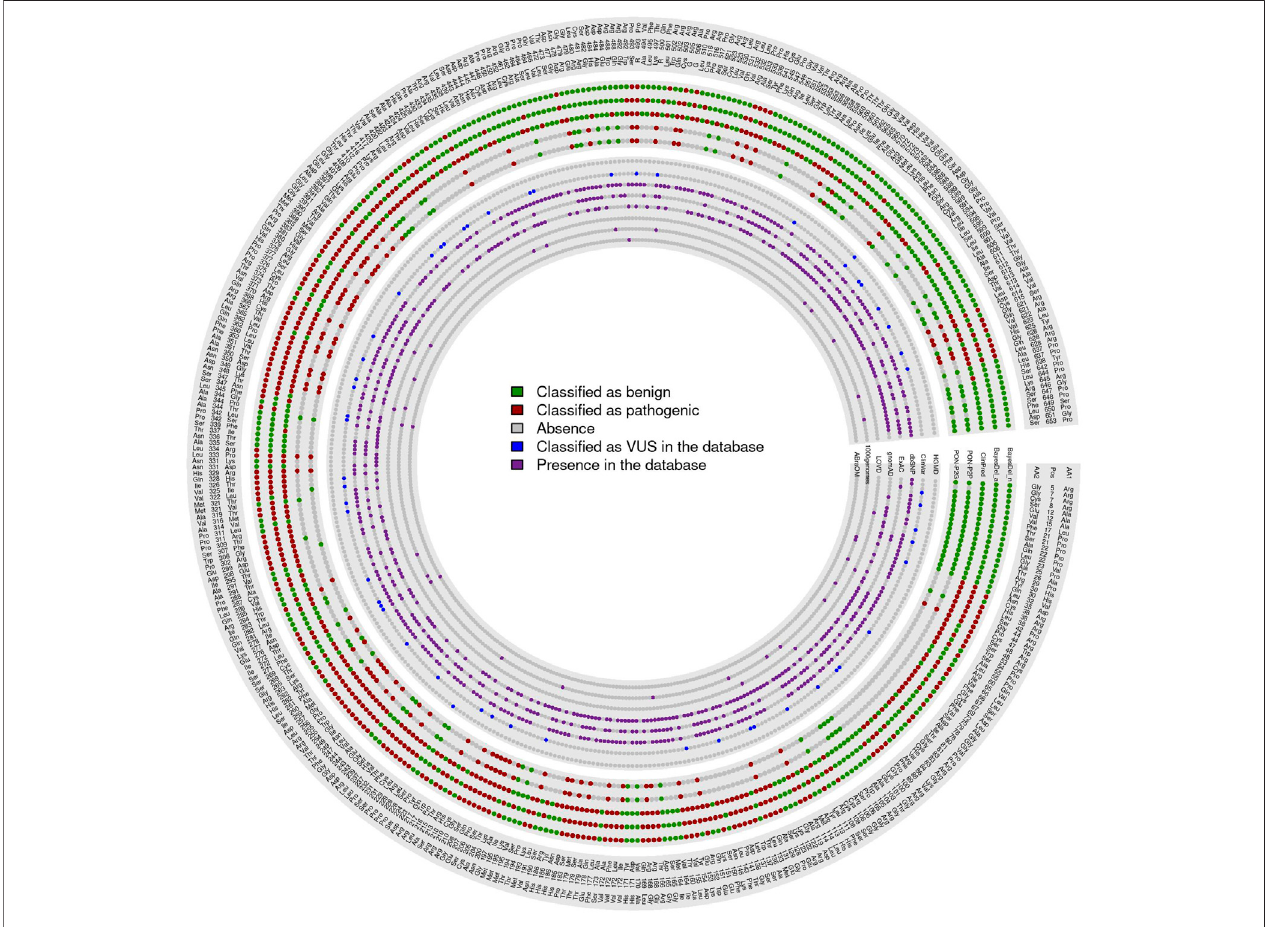
FIGURE 6 | VUS classi fi ed by all best